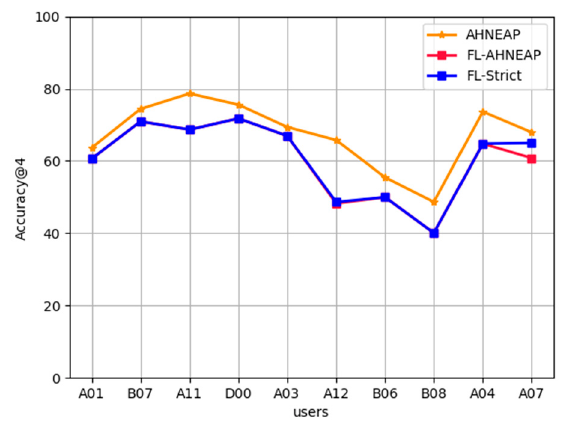
Figure 3. AHNEAP vs. FL-AHNEAP.